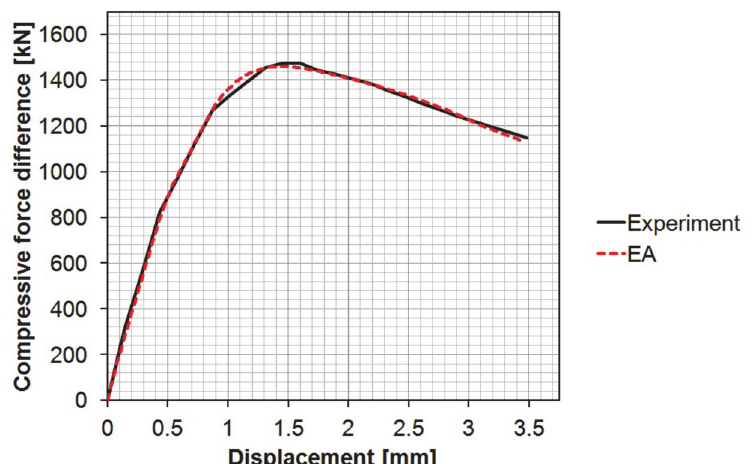
Figure 4: The load-displacement curve for the optimized parameter values compared with the experimental load-displacement curve. C